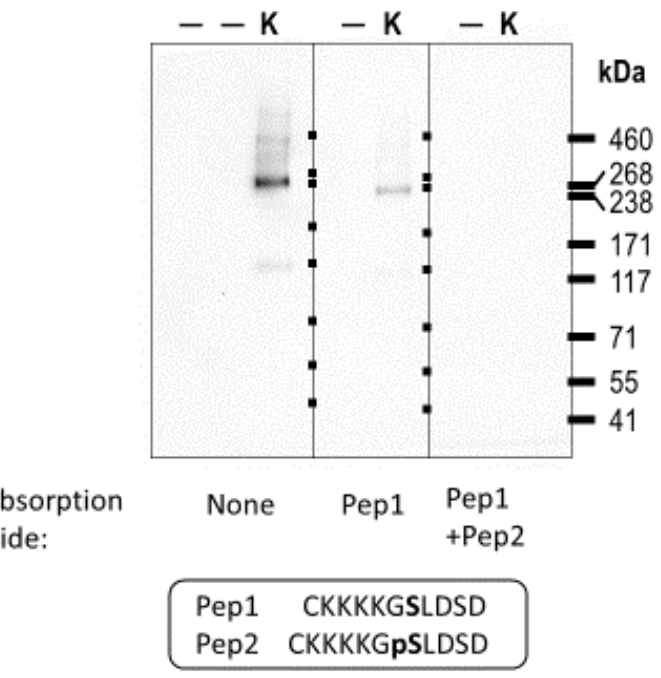
Figure 2. Validation of the pSer982 antibody. Western blot showing anti-pS982 immunoreactivity in murine kidney protein lysates (K = kidney lysate containing lane; — = blank lane). For the middle and right blots, the antibody was preabsorbed with peptides representing the non-phosphorylated version of the epitope (Pep1) with and without a peptide representing the phosphorylated epitope (Pep2).